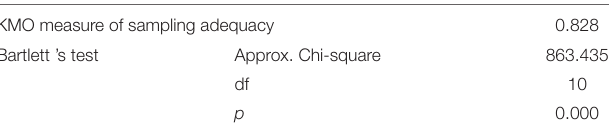
TABLE 4 | KMO and Bartley’s sphere test.